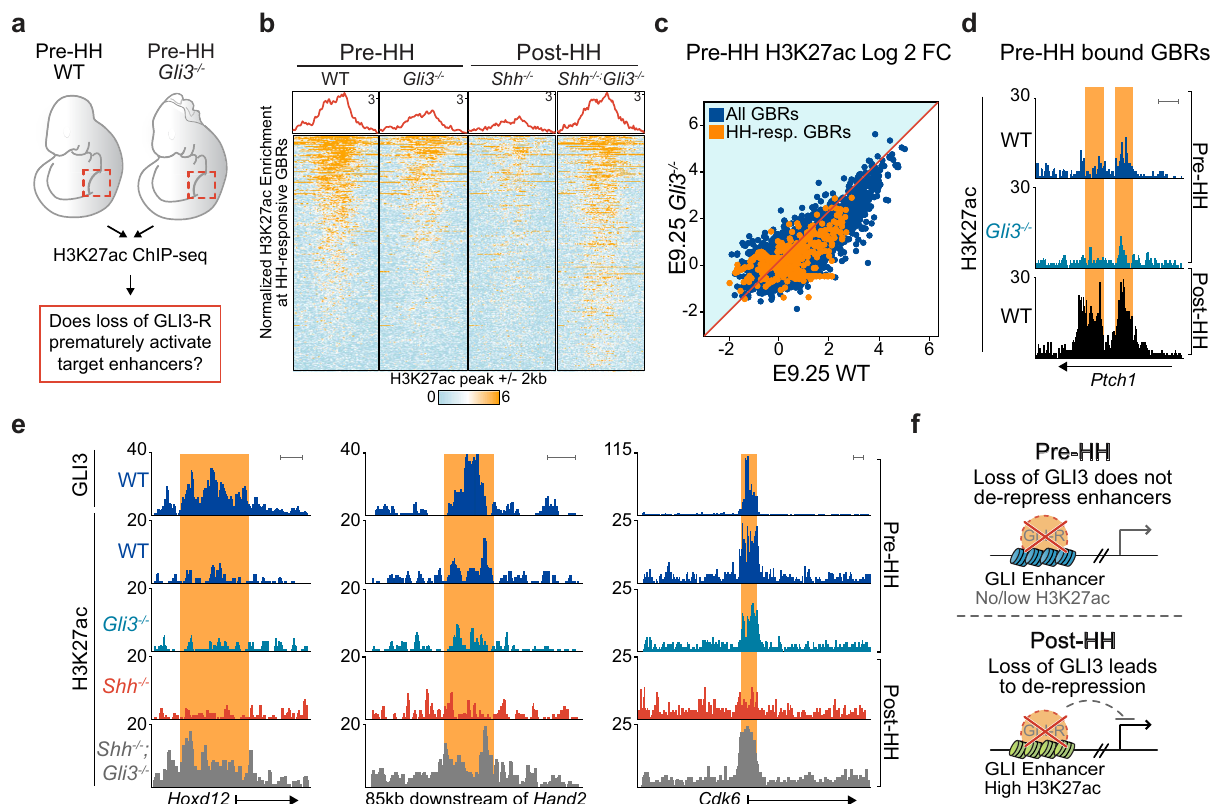
Fig. 3 Loss of Gli3 does not result in premature de-repression of enhancers. a Schematic for testing whether loss of Gli3 prematurely increases H3K27ac levels through GLI3 de-repression. b Heatmap of H3K27ac enrichment at HH-responsive GBRs in pre-HH (E9.25, 21 – 23 S) and post-HH (E10.5, 33-34 S) limb buds, with loss of Gli3 . At E10.5, Shh − / − limbs have reduced H3K27ac due to GLI3 repression. Loss of Gli3 in Shh − / − ;Gli3 − / − results in de-repression of target enhancers and increased acetylation. This change is not observed prior to HH signaling with loss of Gli3 compared to WT limb buds. c Scatterplot of H3K27ac enrichment in pre-HH WT vs. Gli3 − / − limbs shows no increase in acetylation with loss of Gli3 . d H3K27ac ChIP-seq tracks at a pre-HH GLI3- bound HH-responsive GBR with low H3K27ac in E9.25 WT limb buds that does not increase acetylation levels in E9.25 Gli3 − / − . e Examples of regions, bound by GLI3 at E9.25, that do not increase H3K27ac levels with loss of Gli3 in pre-HH limb buds as they do in Shh − / − ;Gli3 − / − post-HH limbs. f Schematic depicting loss of Gli3 in pre-HH limb buds does not lead to de-repression of target enhancers as it does after HH induction at E10.5. Orange shading on tracks indicates HH-responsive GBRs de fi ned in Supplementary Fig. 1e. Scale bars = 1